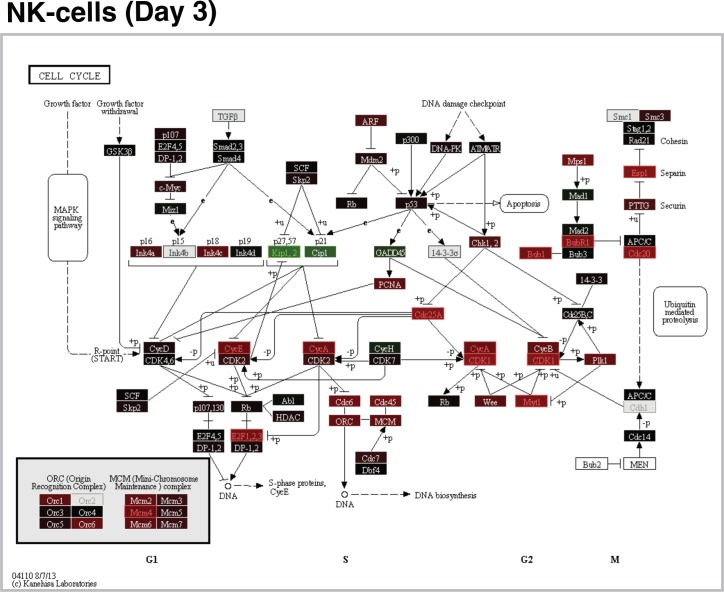
AS03-adjuvanted H5N1 vaccination resulted in increased cell cycle responses in NK-cells relative to non-adjuvanted vaccine 3 days post-vaccination.The pathway map is based on the KEGG Cell cycle pathway. Pathway node color gradient encodes log2 fold change difference (LFCD) between vaccine groups (for multi-gene nodes the median LFCD is used). In red: up-regulated for the SV-AS03 group compared to the SV-PBS group, in green: down-regulated for the SV-AS03 group, in black: fold change close to 1, in dark grey: genes filtered out due to low overall expression, light grey: gene missing database mapping, white: non-human gene. DE genes are highlighted using red and green label colors.